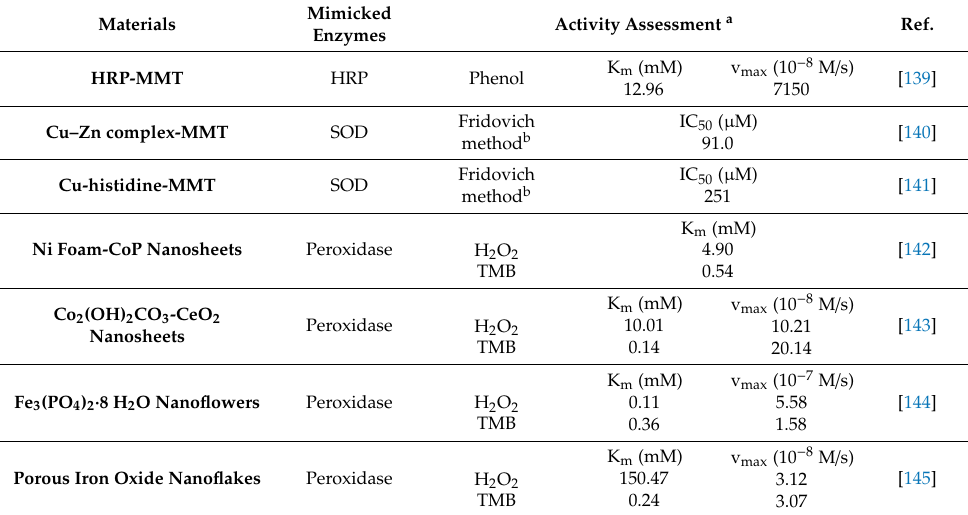
Abbreviation list: TMB: 3,3’,5,5’-tetramethylbenzidine, SOD: superoxide dismutase, GSH: glutathione, HRP: horseradish peroxidase, XO: xanthine oxidase, DPPH: 2,2-diphenyl-1-picrylhydrazyl, CUPRAC: cupric reducing